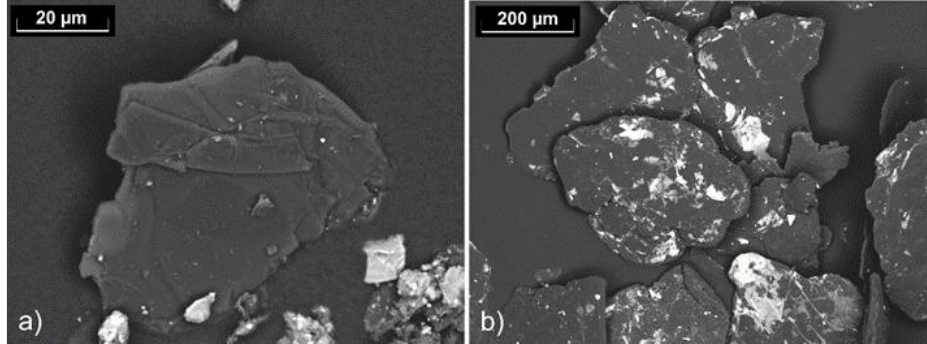
Figure 5. Backscattered electron micrographs showing ( a ) a graphite flake contained in the 0 – 1 mm fraction of the recyclate and ( b ) graphite NFL90/92. 0–1 mm fraction of the recyclate and ( b ) graphite